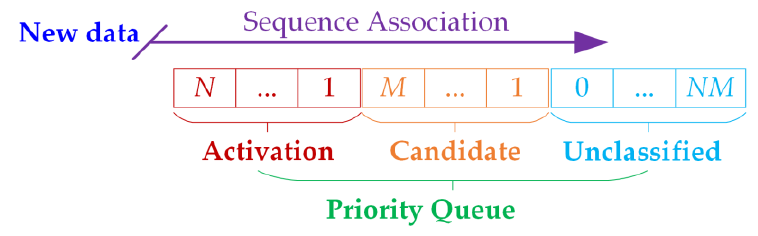
Figure 2. Priority data association policy diagram.